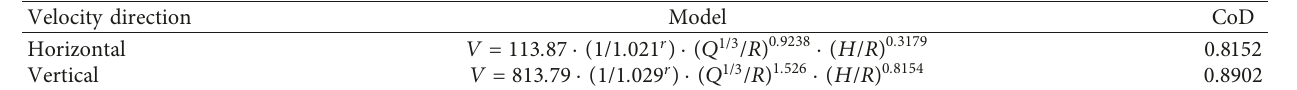
Table 7: Fitting results of PPV by the new model.